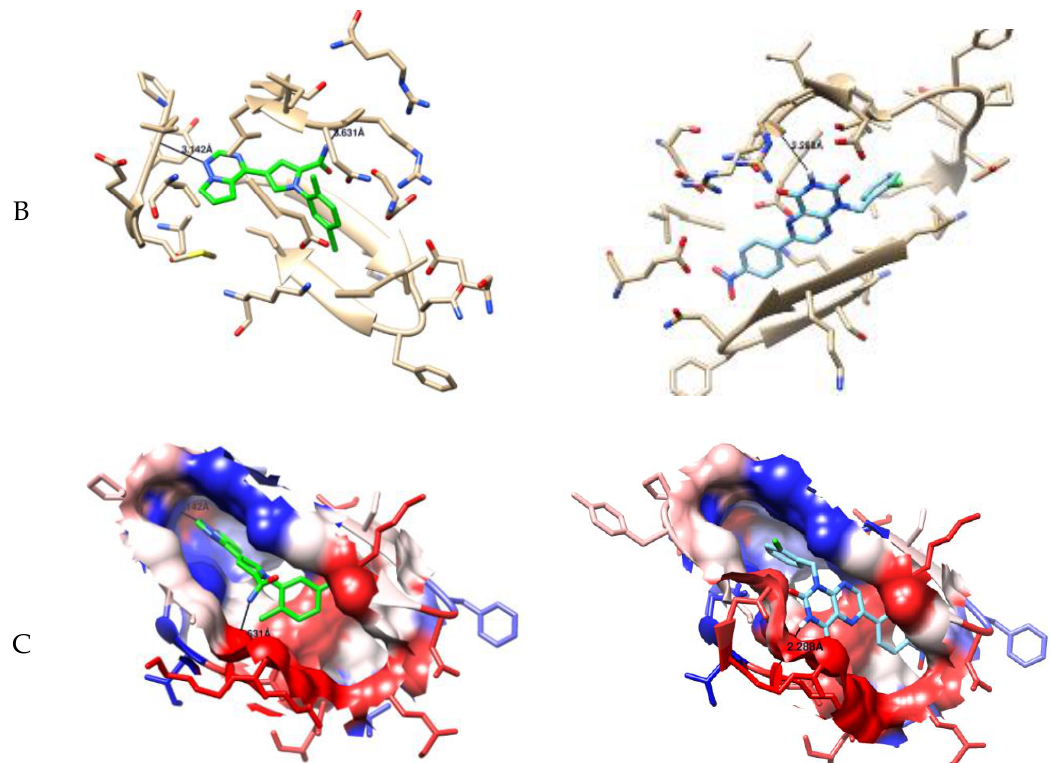
Figure 4. The interaction of compound 7d with Jak2 protein compared to reference ligand (RL), ( A ) 3D interaction, ( B ) hydrogen bond formation, and ( C ) hydrophobic interaction representation by blue color.